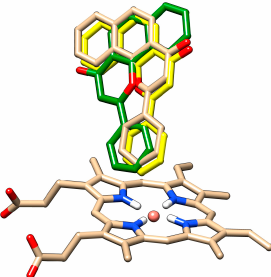
Figure 6. Comparison of the docked alpha-naphthoflavone with all water molecules removed (green), docked alpha-naphthoflavone in presence of HOH 733 (yellow), and crystallographic alpha-naphthoflavone (brown) in vicinity of cytochrome P450 1A2 heme. Oxygen atoms are depicted in red, nitrogen atoms in blue, hydrogen atoms in white, and heme iron in orange.